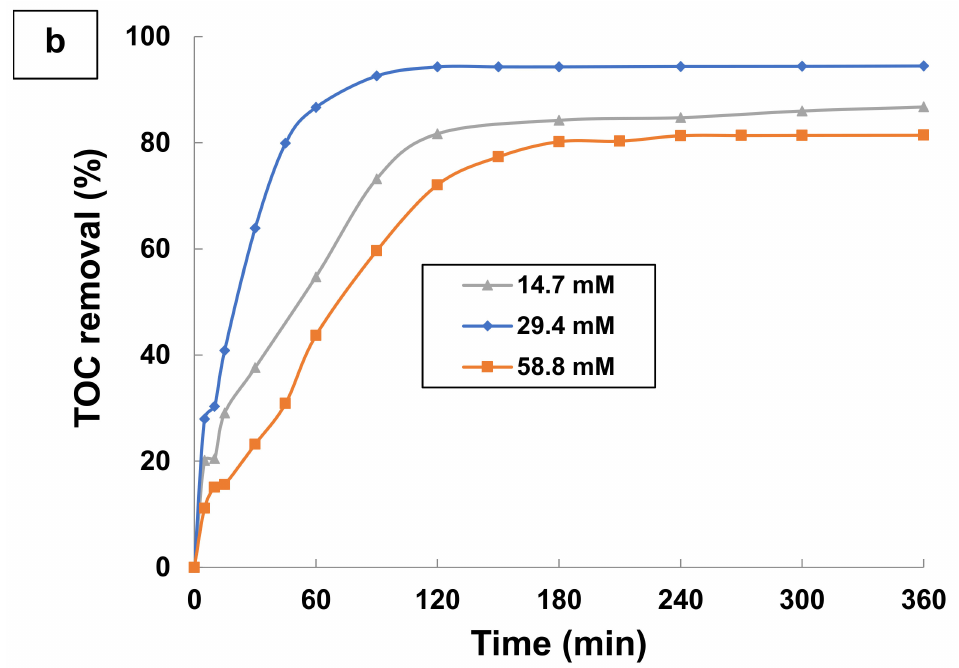
Figure 7. Effect of H 2 O 2 dose on ( a ) Aromatics removal and ( b ) TOC removal by photo-Fenton process (UV/H 2 O 2 /Fe 2+ ). Experimental conditions: [TA] = 0.1 mM; [H 2 O 2 ] = 14.7–58.8 mM; [H 2 O 2 ]/[Fe 2+ ] = 164; T = 25 ◦ C; and pH =